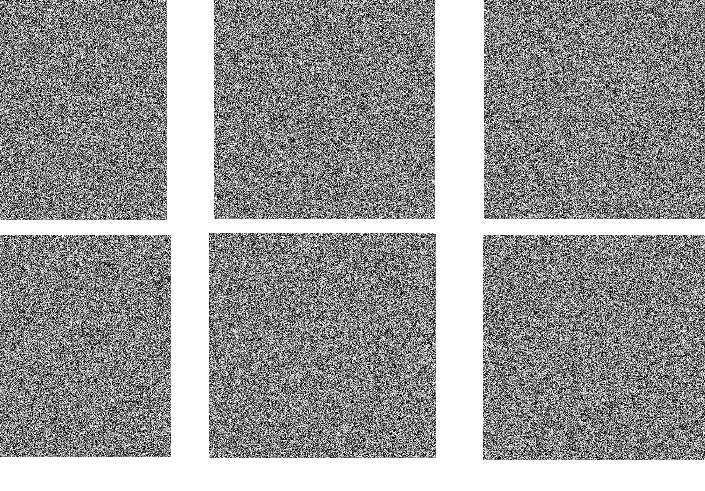
Figure 11. Samples of fingerprint corresponding kernels.